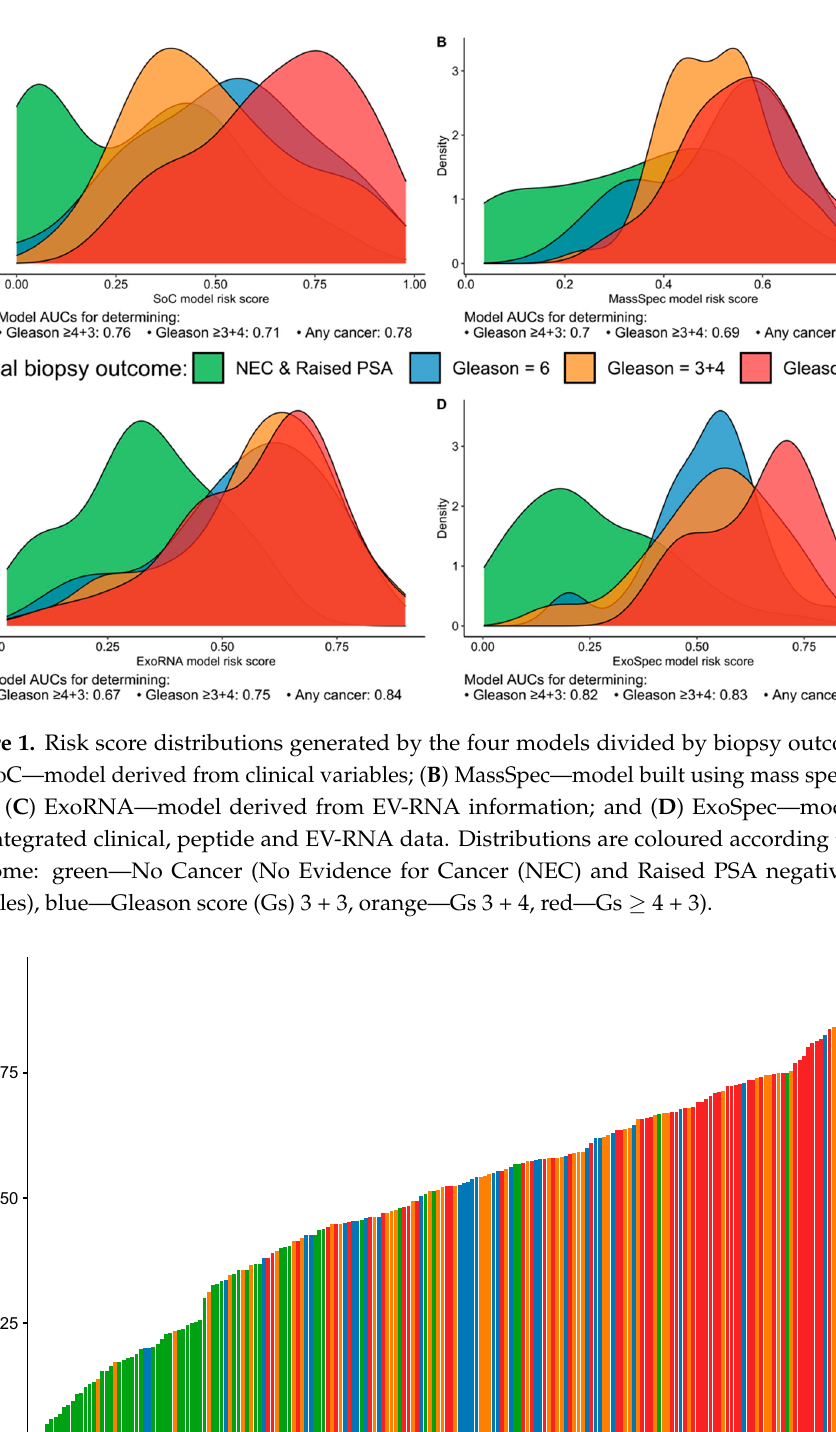
Gleason score (Gs) is associated with more aggressive disease). The height of each coloured bar is the predicted risk score given by the ExoSpec model for an individual biopsy. The colour of the bar represents the biopsy outcome: green—No Cancer; blue—Gs 3 + 3; orange—Gs 3 + 4, red—Gs ≥ 4 + 3.